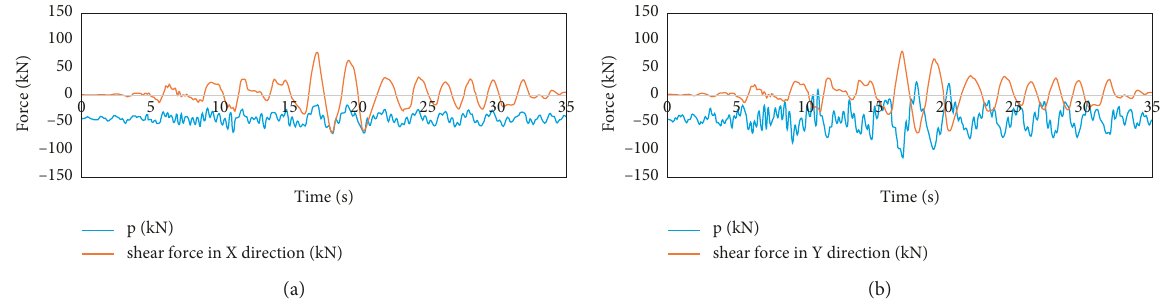
Figure 41: Time course curves of bearing stresses under LWD seismic waves. (a) X-directional input. (b) Y-directional input.